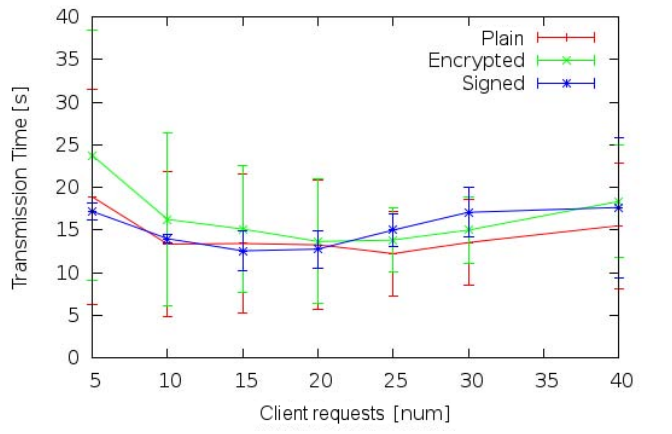
Figure 10. Trasmission time between domain A CM and domain B